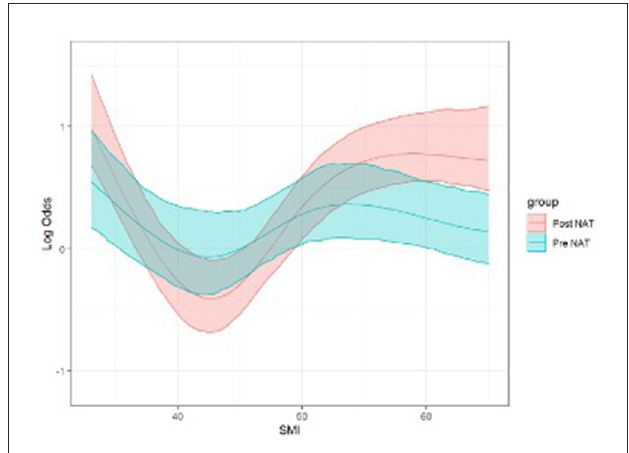
FIGURE1 Logistic regression model for postoperative morbidity risk (log-OR) according to SMI (Pre- and Post-NAT) adjusted per gender and age ( p < 0.001, see text). Both linear ( p = 0.01) and non-linear ( p = 0.02) effects are significant. NAT, Neoadjuvant therapy; SMI, skeletal muscle index (cm 2 /m 2